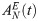
Mean-field approximation of synaptic input for randomly connected networks.The same E-I network as in Fig 5 with N = 500 neurons and connection probability p = 0.2 was simulated for increasing synaptic strength wEE = wIE = w (wEI = wII = −5w) of excitatory (inhibitory) connections: (A, B) w = 0.25 mV, (C, D) w = 0.5 mV (E, F) w = 1 mV. (A, C, E) Top: Membrane potential of one example neuron shows fluctuations due to spike input from C = 100 presynaptic neurons (black line), which represent a random subset of all 500 neurons. The mean-field approximation of the membrane potential (dashed red line) assumes that the neuron had the same firing times but was driven by all neurons, i.e. by the population activities ANE(t) and ANI(t), with rescaled synaptic strength wMFE/I=pwE/I. Although individual membrane potentials differ significantly from the mean-field approximation (top), the relevant population-averaged hazard rates A¯microE/I(t)≡1NE/I∑i=1NE/Iλ(t|t^i) (bottom) are well predicted by the mean-field approximation. (B, D, F) Corresponding power spectra of the (excitatory) population activity for microscopic (circles) and mesoscopic (blue solid line) simulation. Parameters as in Fig 5 except μE/I = 18 mV.